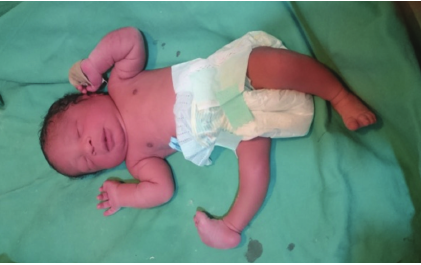
Figure 1: The baby following